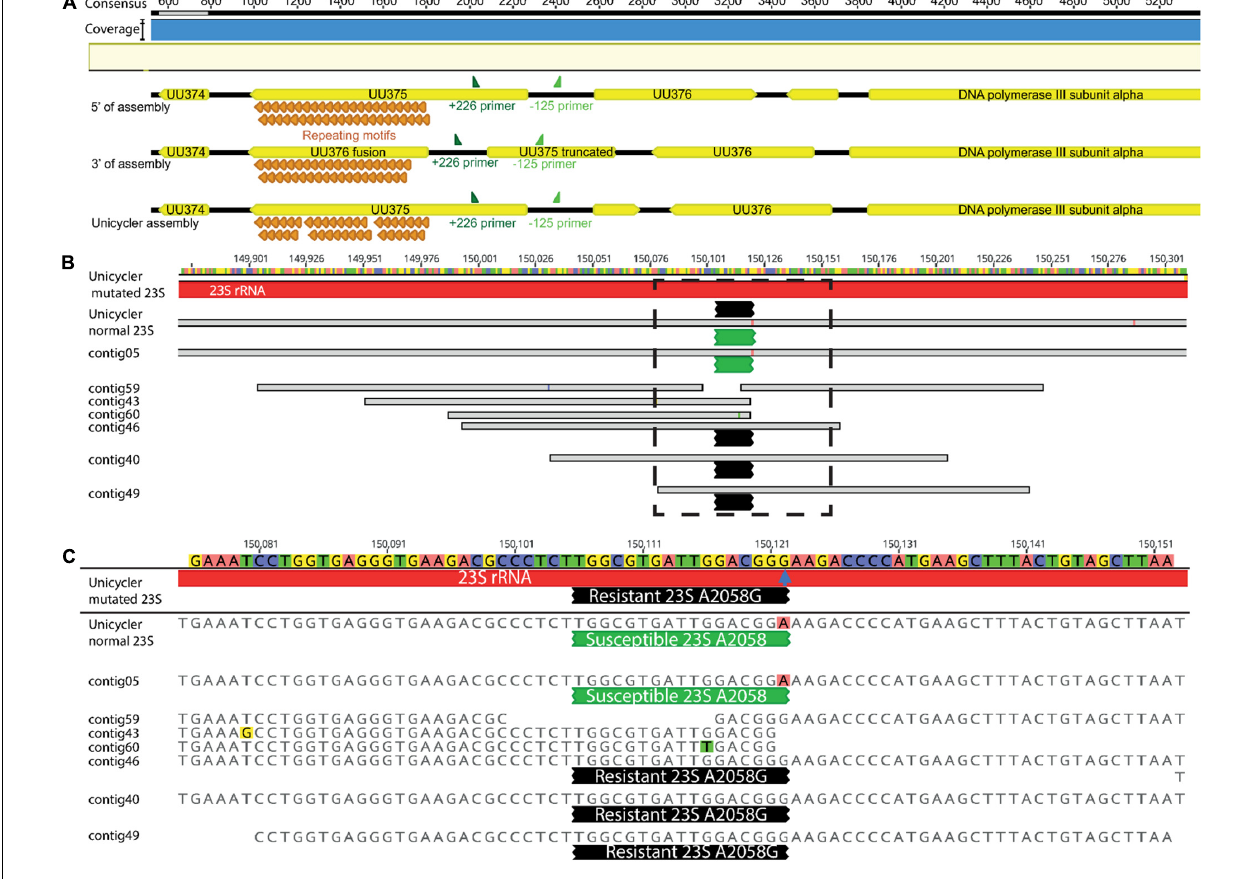
FIGURE 10 | A schematic to visualize (A) 3 (cid:48) and 5 (cid:48) end s of the Canu-based assemblies indicating they have both, versions of the UU375 rearrangement vs. Unicycler (as well as the adjacent non-inverted genes) at the beginning and end of the assembly, PAGKEQ repeat motifs (orange) and primers +226 and –125 (dark and light green, respectively) are shown for context of the small inverted region; (B) the alignment short reads to the Unicycler assembly of MIN-201 (Ureaplasma urealyticum), bases representing mismatches in base calls are identified with different color highlighting and contigs containing 23S rRNA mutations at A2058G (blue arrow) mediating resistance are identified at the end of the black probed region, while contigs containing wild type susceptible 23S rRNA A2058 are identified by green probed regions, (C) shows a higher resolution of the region identified by a dotted box in (B)